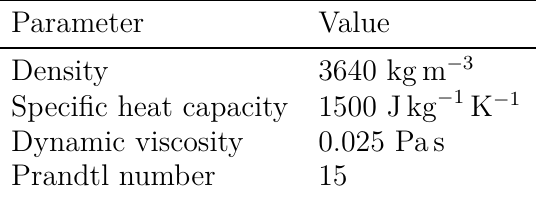
Table I: Fluid properties